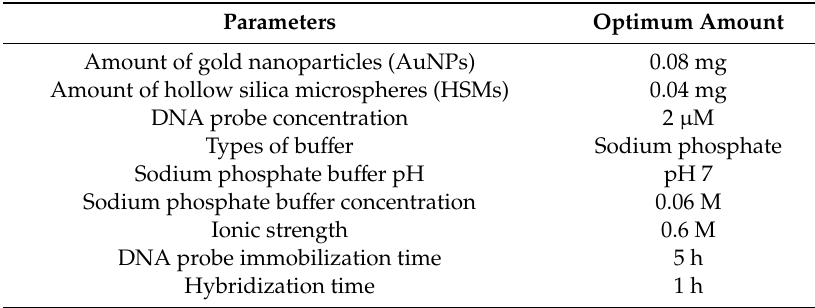
Table 1. The optimum parameters for the label-free DNA